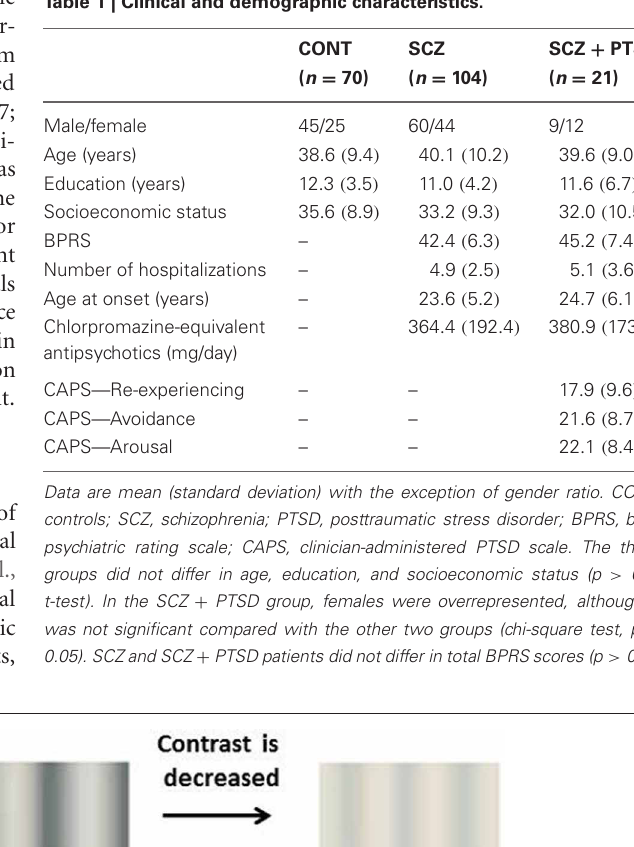
FIGURE 1 | Illustration of the principle of contrast sensitivity measurements. The spatial frequency of a grating is reduced when the cycles (vertical bars with high and low luminance) under 1 ◦ is decreased.